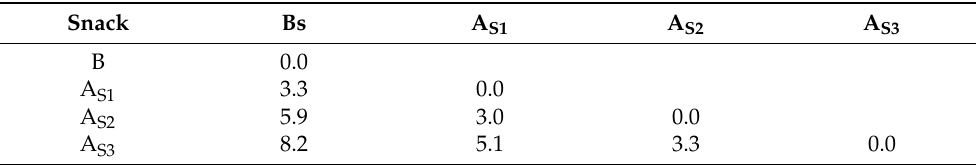
Table 9. Soft independent modeling of class analogy interclass distances from a 4-class SIMCA A. diaperinus snack model. Abbreviations used: Bs, blank snack with 0% insect powder; As 1 , snack with